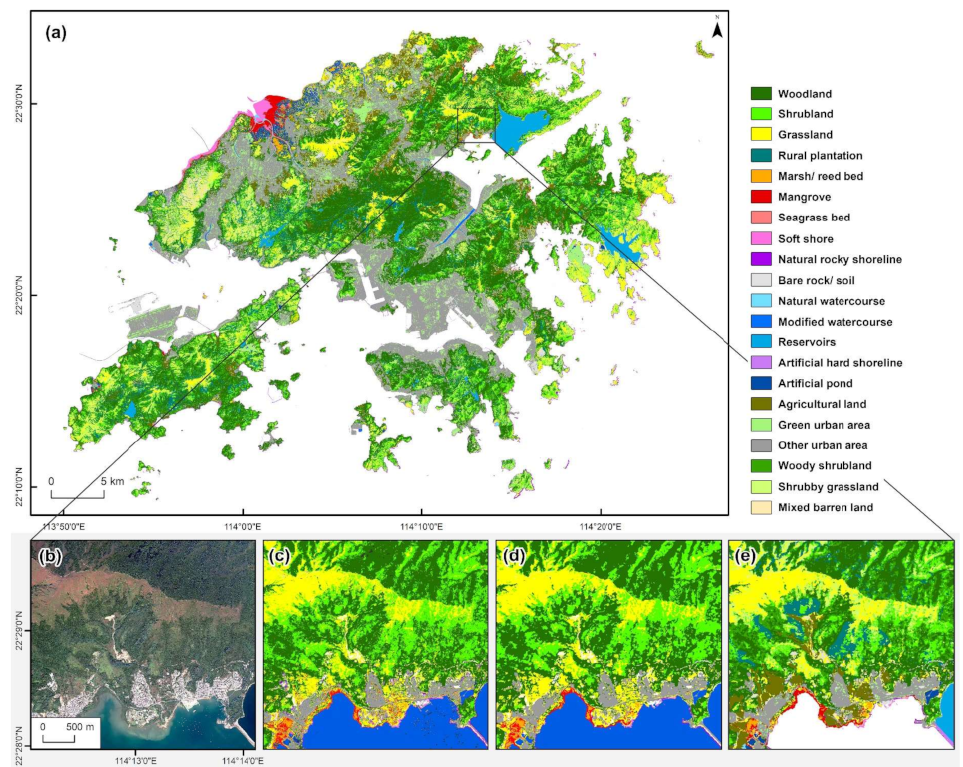
Figure 8. ( a ) The habitat map produced in this study consisting of 21 categories; ( b–e ) selected area for visualizing the results at different stages of the mapping procedures; ( b ) true-colour composite of the WorldView image; ( c ) initial classification with 11 classes in stage 1 produced using pixel-based RF method; ( d ) refined classification map with 10 classes in stage 2; ( e ) habitat map with 21 classes in stage